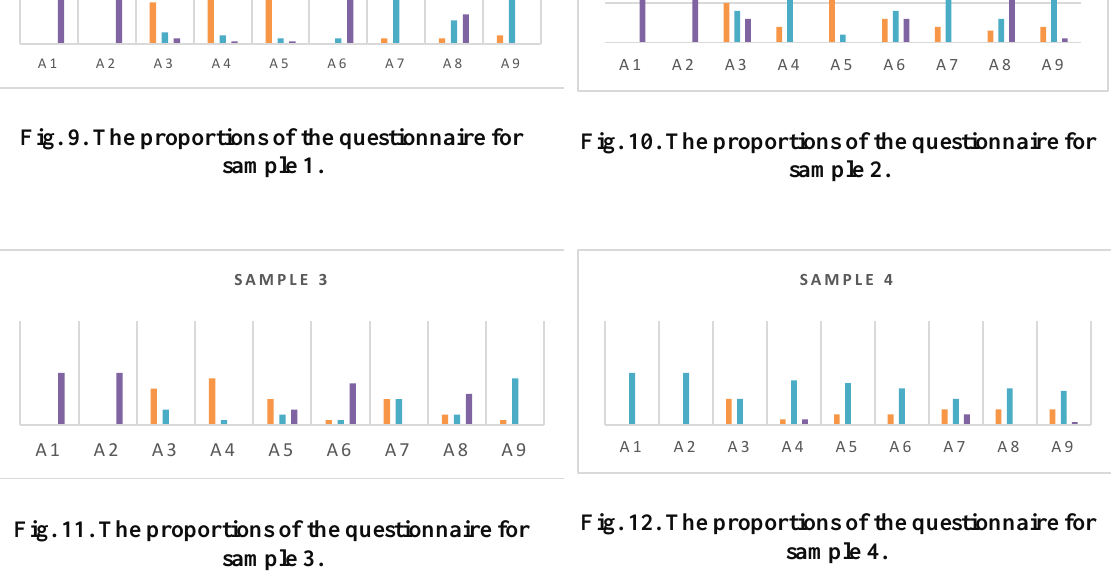
Fig. 11. The proportions of the questionnaire for sample 3.